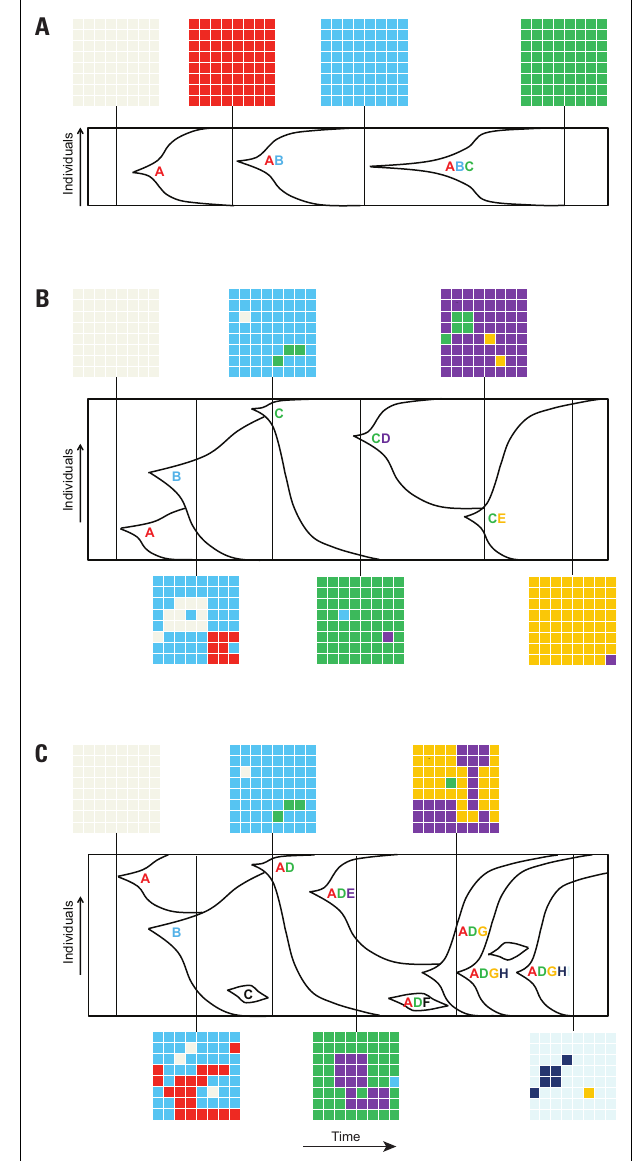
FIGURE 2 |Theories governing population structure during asexual evolution. The graphs represent the population structure as a function of time during asexual evolution.The capital letters represent different beneficial mutations in the population.The gridded boxes represent a snapshot of the frequency of different genotypes in the population at that one point in time. (A) Clonal replacement model, where successive sweeps and fixation of different beneficial mutations take place in a small population; snapshots of the genotypes at different elapsed times show that the population is homogeneous except when the beneficial mutant is sweeping through the population. (B) Clonal interference model, where different adaptive mutants compete until one with the largest fitness advantage sweeps through and becomes the founding genotype for subsequent evolution (e.g., mutations A, B, and C compete until C completely takes over the population). (C) Multiple mutations model, where multiple mutations occur in the same lineage before fixation. In the latter two population structures, some adaptive mutations are lost from the population, and depending on when adaptive mutants are isolated, some mutants (and thus the underlying molecular mechanisms for adaptation) may not be